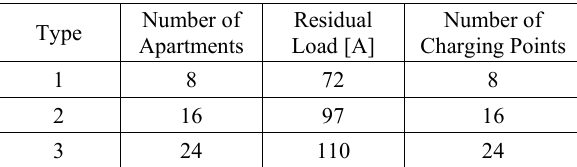
Table 2. Configuration of